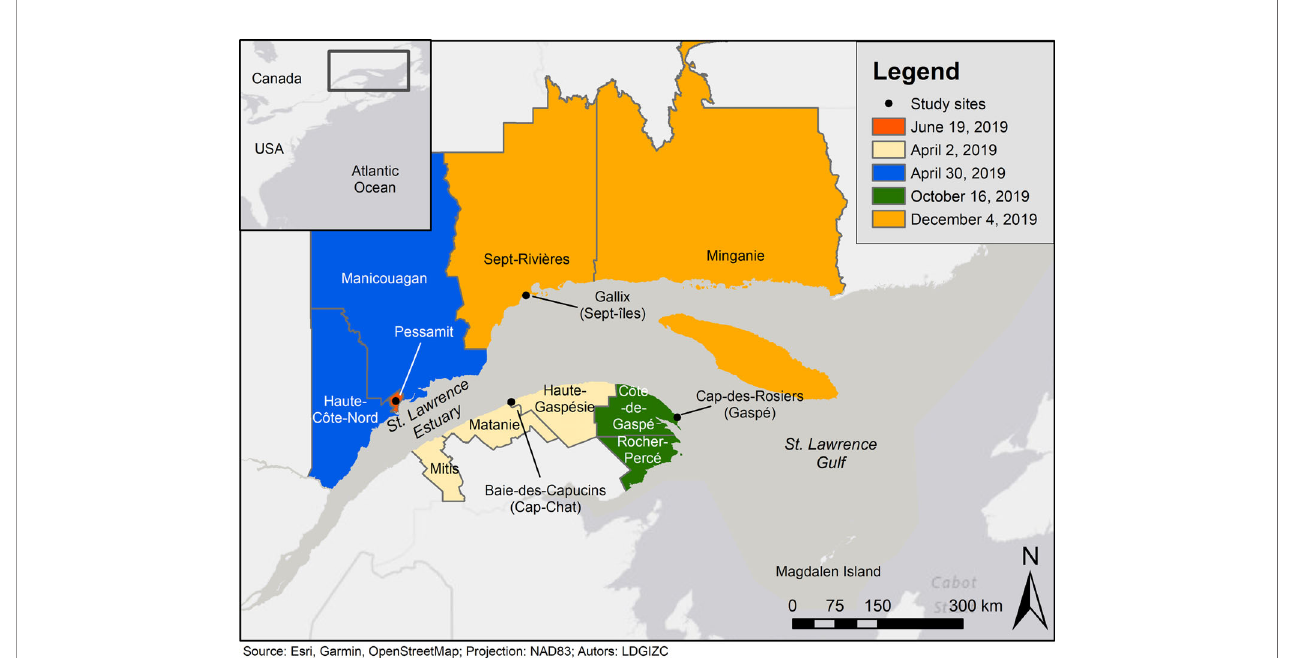
FIGURE 2 | Sites and MRCs from Eastern Quebec included in the study, with the workshops ’ dates in the